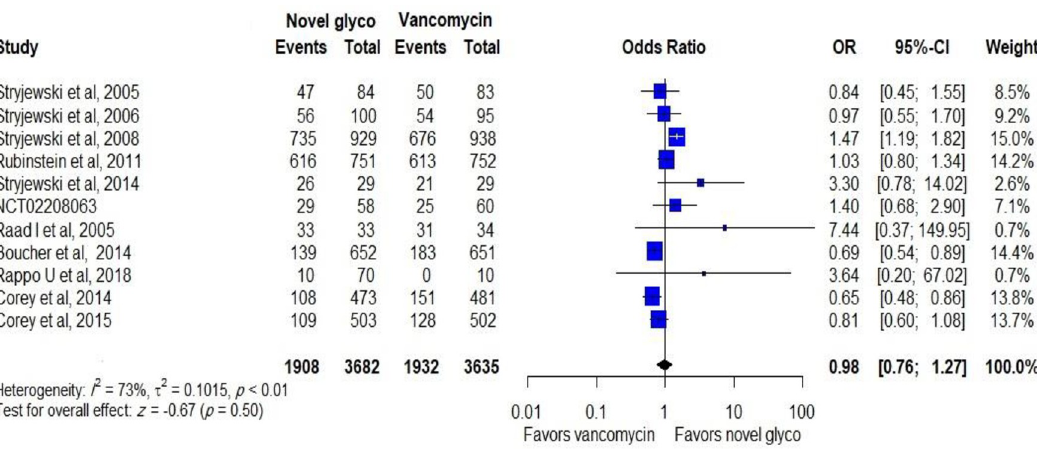
Fig 5. Adverse events of novel glycopeptides against vancomycin in the modified intent-to-treat populations.